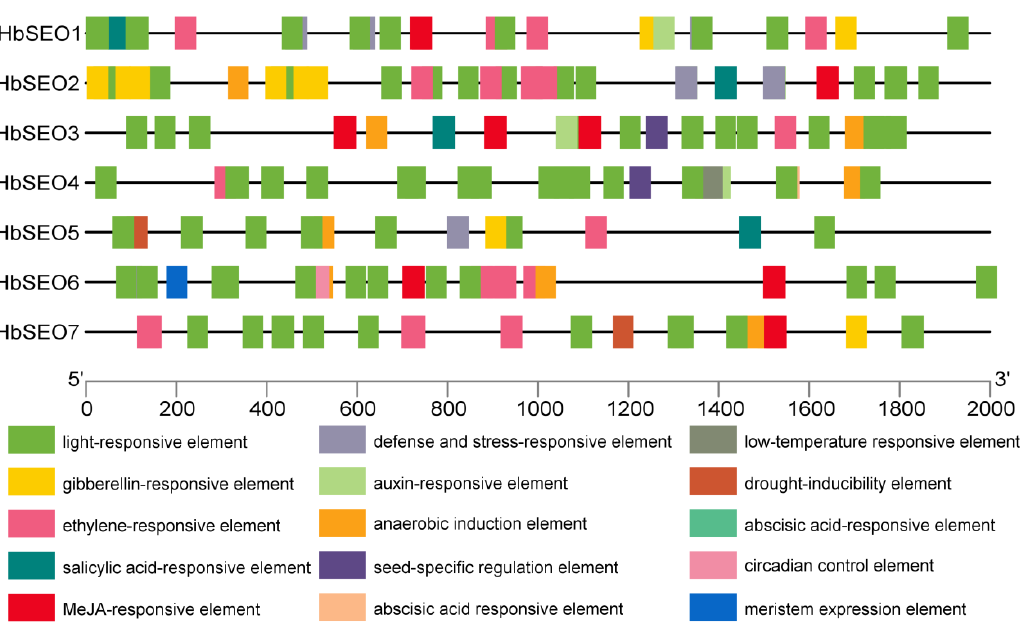
Figure 6. Cis-acting element analyses of HbSEOs. Different color boxes represent different cis-elements. The 2000 bp upstream of HbSEO gene promoter sequences were selected to detect promoter cis-elements using the PLANTCARE database.